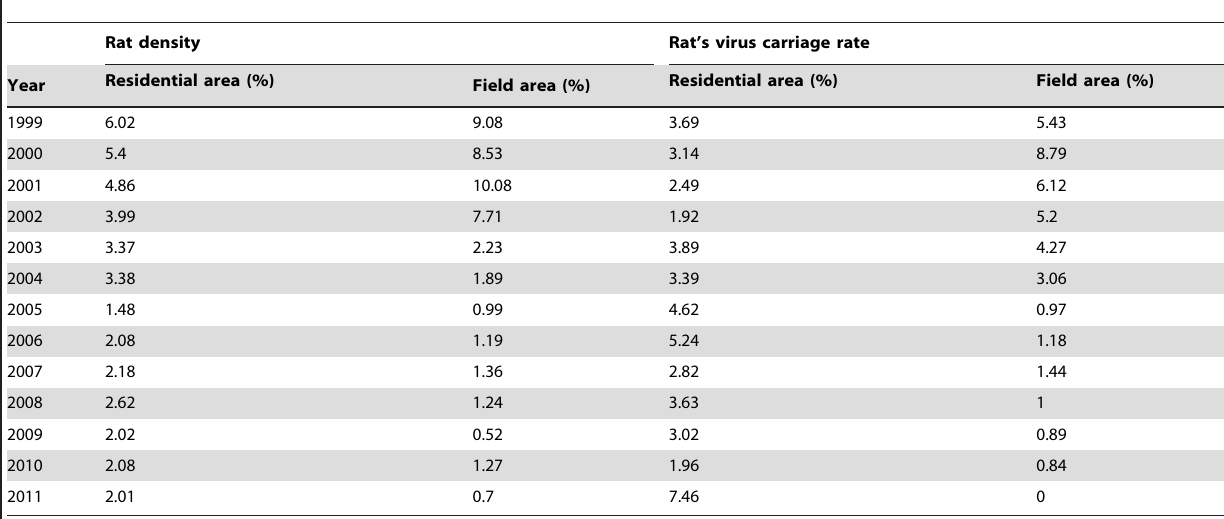
Table 1. Rat density and rat’s virus carriage rate in cities of Hebei province from 1999 to 2011.